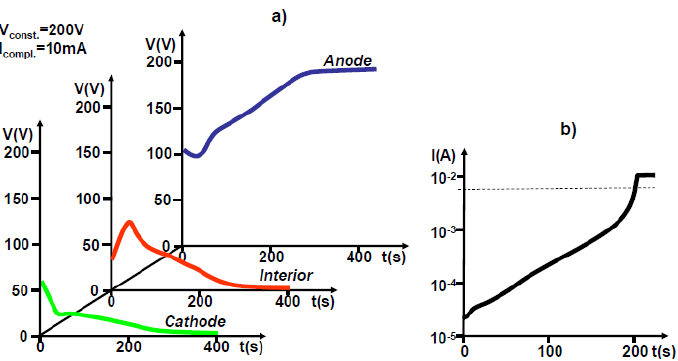
Figure 50. Potential difference change for region close to the anode, cathode and for the bulk during electroreduction of Fe:SrTiO 3 single crystal, by electrical polarization using constant voltage ( a ). Inset ( b ) shows the increase of the current flow through the crystal. Adapted from